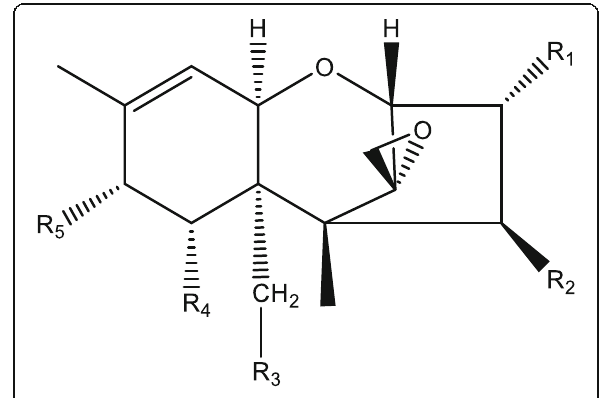
Fig. 1 Structures of trichothecenes (Marin et al., 2013)